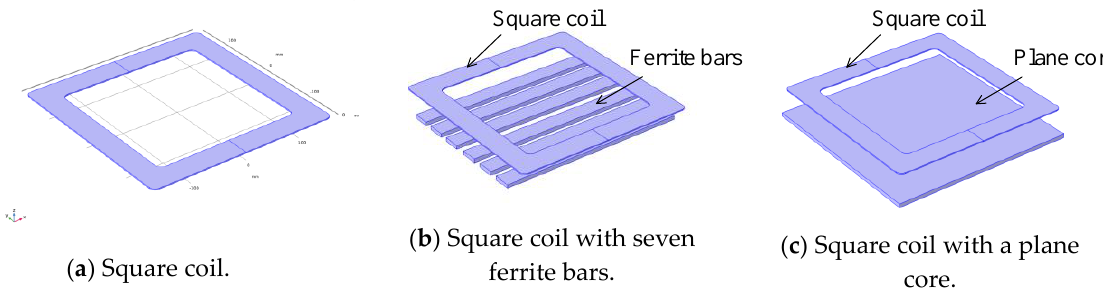
Table 3. Parameters for square coil and ferrite core.